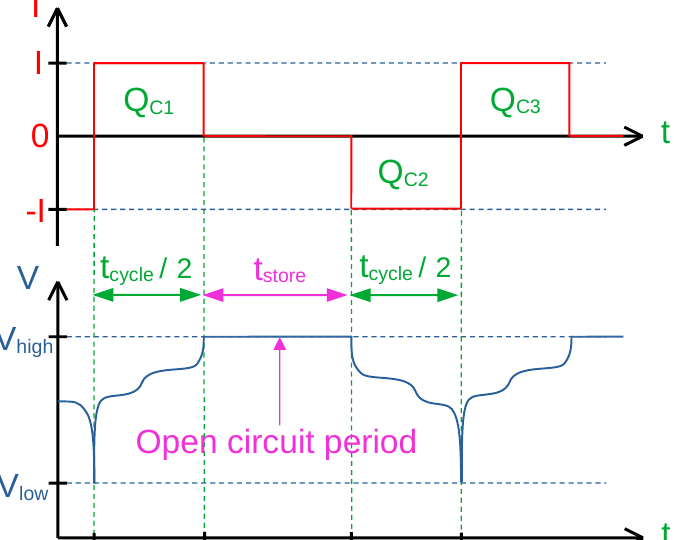
Figure 9. Cycling scheme with open circuit holding period at 100% SoC (“high-SoC-scheme”) to find out calendrical aging and leakage charge at a high state of charge in contrast to the C/x-scheme which always has an average state-of-charge of 50%.